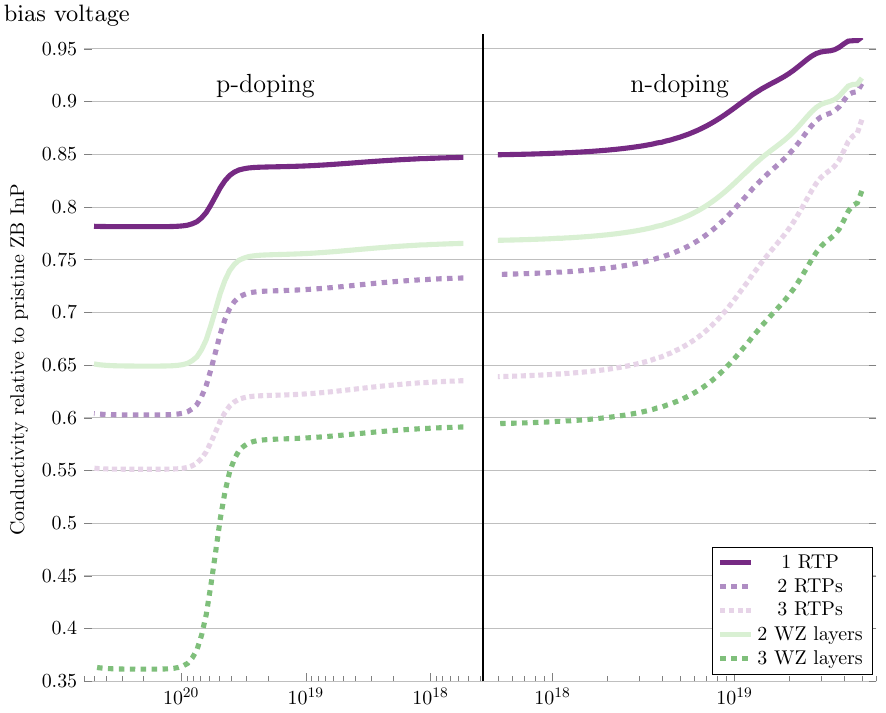
10 17 cm − 3 but with increasing ×